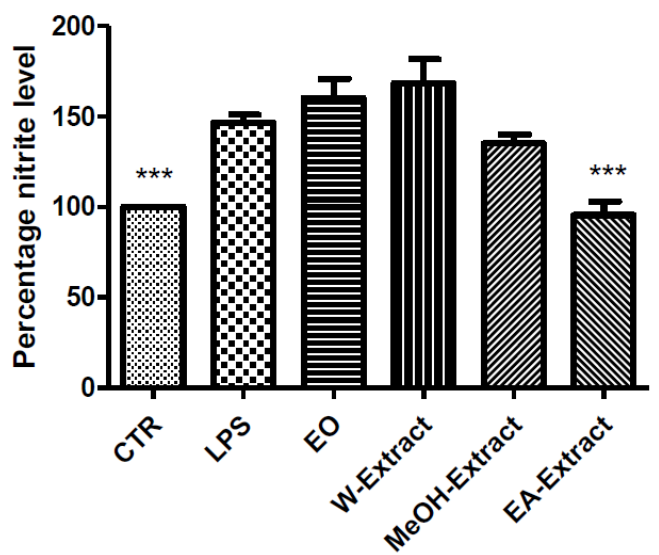
Figure 3. Effect of essential oil (EO) and water (W), methanol (MeOH) and ethyl acetate (EA) A. santonicum extracts (100 µg/mL) on LPS-induced nitrite level in rat colon specimens. Only EA extract was able to restore the level of nitrites observed in control (CTR) group. p < 0.001; post-hoc, *** p < 0.001 vs. LPS.